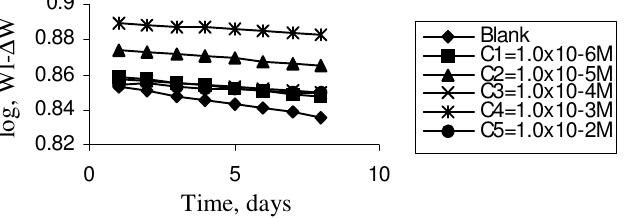
Figure 12. Variation of log (Wi - ∆ W) with time (days) for mild steel coupons in 2 M HCl solutions containing different concentration of pyridoxolhydrochloride at